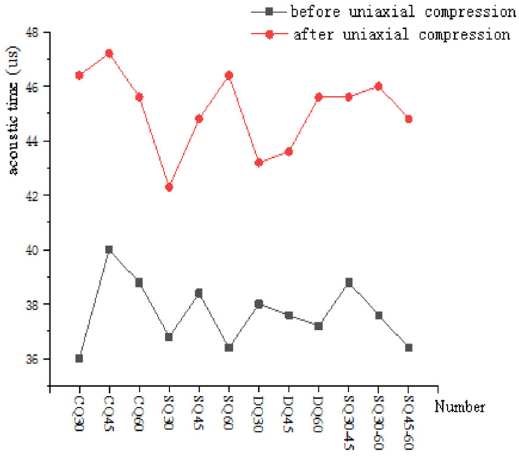
Fig. 10 Sound variation, before (black square) and after (red circle) the uniaxial